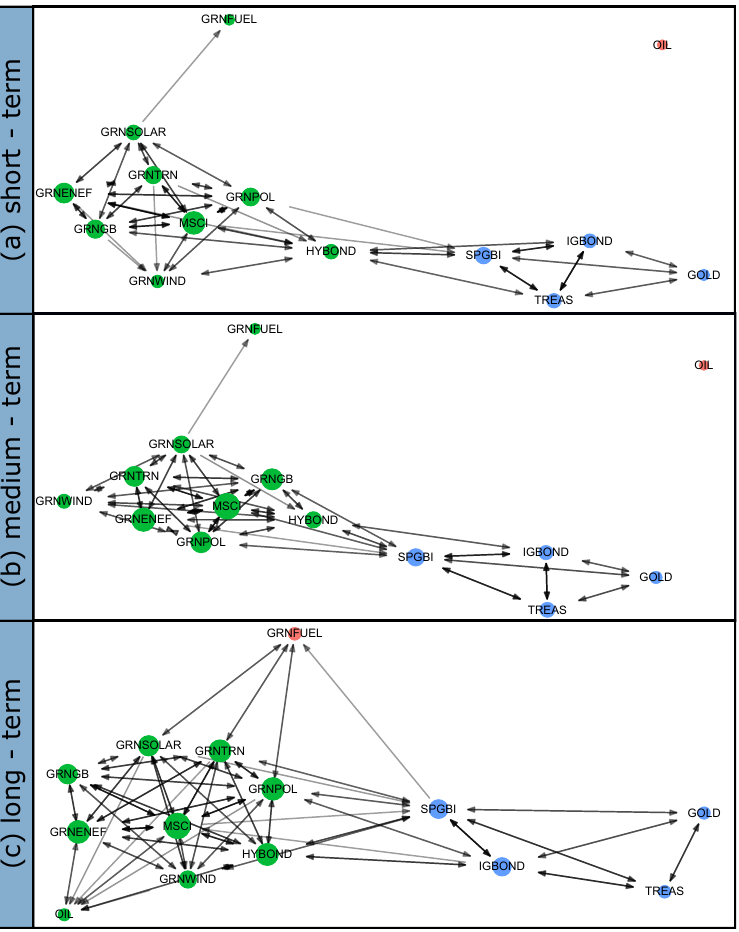
Figure 1. Wavelet coherence-based networks over the full sample for the three frequency bands con- sidered. ( a ) short-term, between 2 and 5 days; ( b ) medium-term, between 5 and 22 days; ( c ) long-term, more than 22 days. Source: own elaboration using the R statistical software [65] together with pack- ages wavScalogram [66], igraph [67], and ggraph